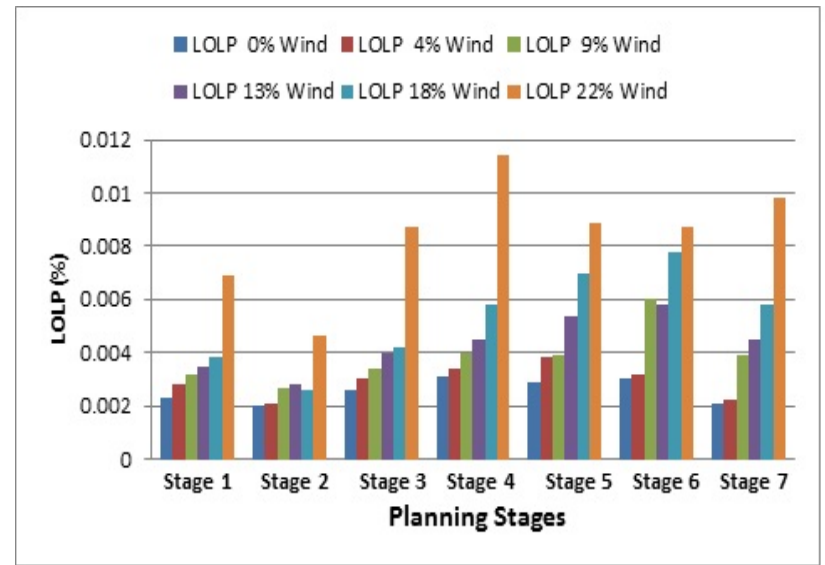
Figure 5. Changes in loss of load probability (LOLP) plans with different type 1 wind regimes.